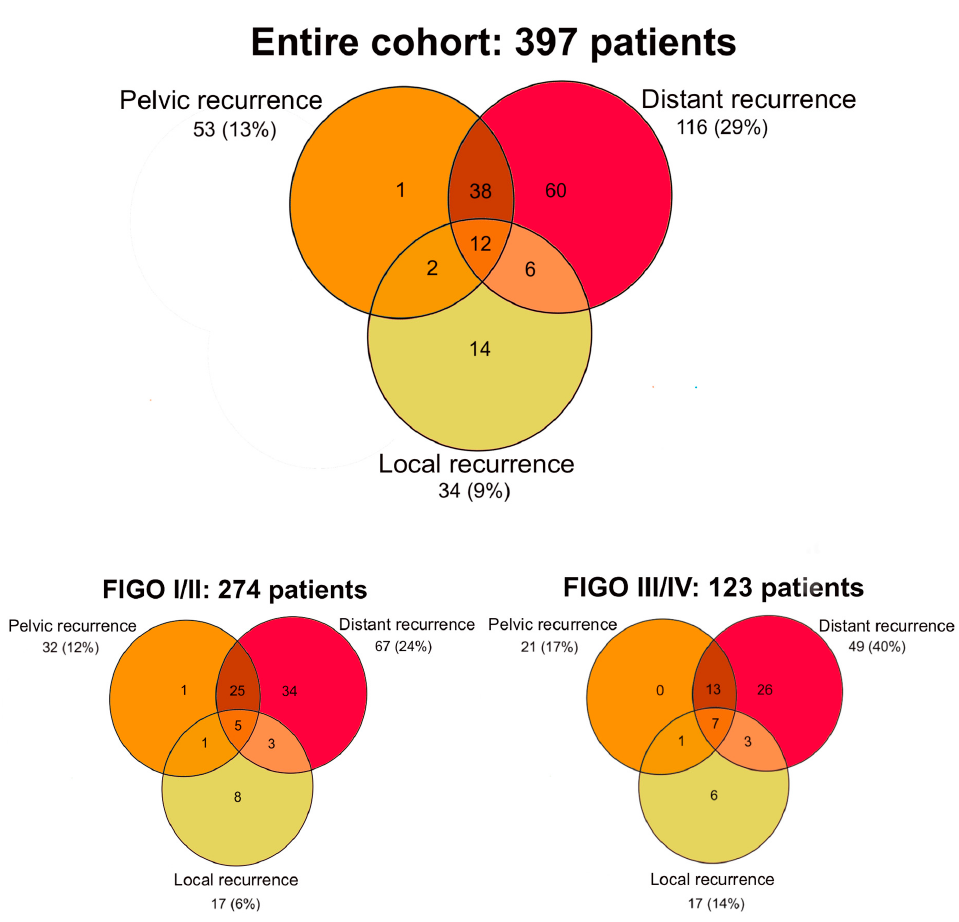
Figure 3. Venn diagrams of local, pelvic, and distant recurrence rates for the entire cohort and strat- ified by FIGO 2009 stage